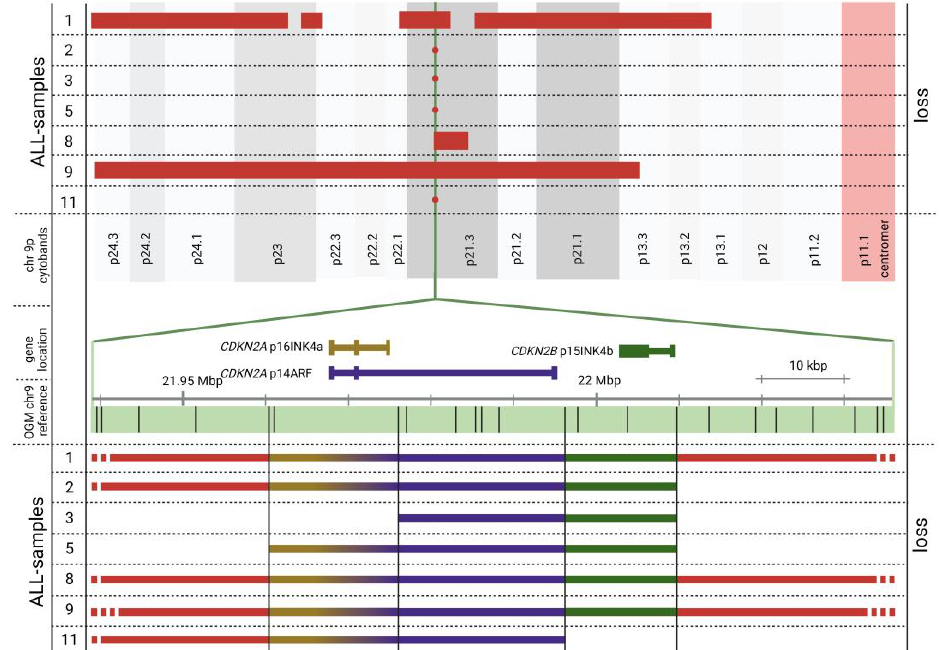
Figure 3. Estimated minimal region of overlap for CDKN2A and CDKN2B deletions on chromosome 9p (minus strand) based on OGM data. Large 9p deletions ( top ) and detailed view of 9p21.3 CDKN2A and CDKN2B genomic region (middle, bottom) are depicted. Top: Large losses of genomic material are shown as red bars, small deletions as red dots at the top. Detailed view of CDKN2A and CDKN2B genomic region includes the CDKN2A alternative reading frame and respective transcripts ( CDKN2A transcripts p16INK4a and p14ARF and CDKN2B transcript p15INK4b). Colors of the deleted regions correspond to the affected transcripts. OGM label positions at breakpoint regions are vertically extended to the bottom of the figure. A minimal region of overlap can be hypothesized that affects the alternative reading frame of CDKN2A (p14ARF transcript) based on OGM data. Created with